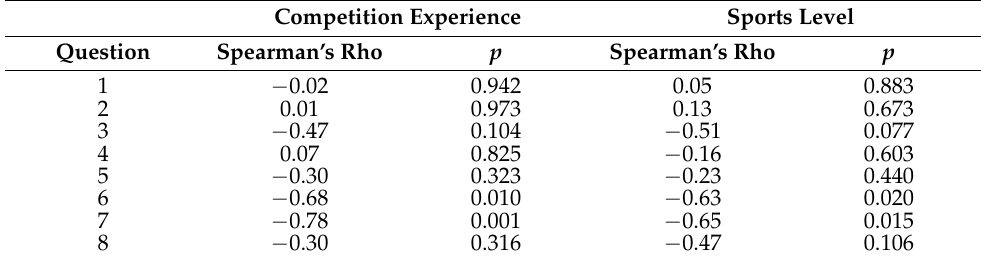
Table 2. Spearman’s rank correlations coefficients between answers from the questionnaire (Q1–Q8) and competition experience as well as sports